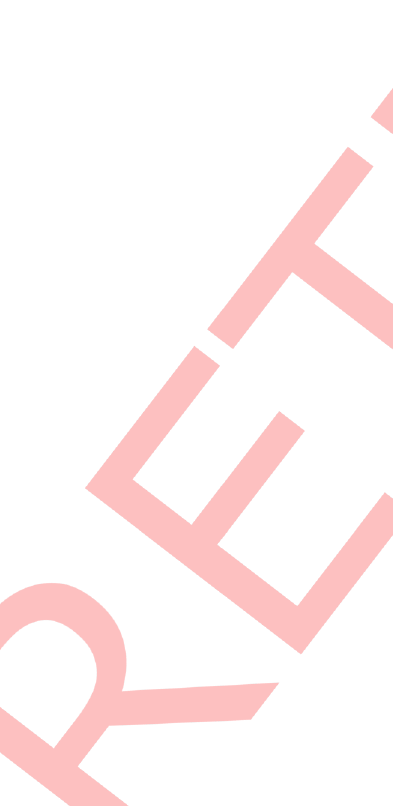
Fig 8. SEM image of the untreated control bacteria (A,B,C,D,E,F,G,H) and the CPG-S NPs treated plant pathogenic bacteria (I,J,K,L,M,N,O,P). P . syringae pv. tobacci (Pstab) [A,I]; P . syringae pv. tobacci 11528 (Pstab11528) [B, J]; P . syringae pv. tomato T1 (PstT1) [C,K]; P . syringae pathovar tomato DC3000 (virulent) [D,L]; P . syringa e pathovar tomato DC3000 (Avirulent) [E,M]; P . syringae pv. actinidiae (Kyu-10) [F,N]; P . syringae pv. actinidiae (Kyu-16) [G,O]; X . smithii pv. citri (Yu-1)